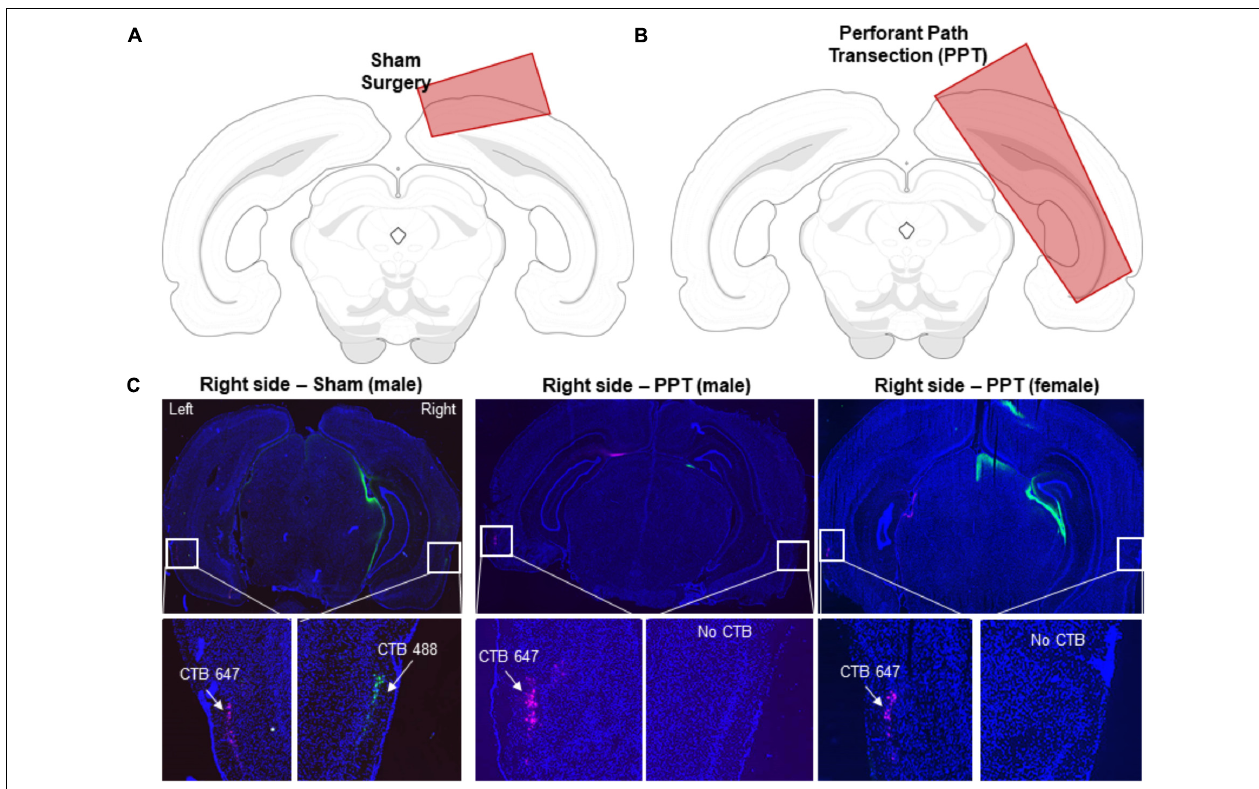
FIGURE 2 | Verification of perforant path fiber transection. (A) Schematic of the extent of the sham knife cut through the cortex in a coronal section of the rat brain. (B) Schematic of the extent of the knife cut used to transect the perforant path in a coronal section of the rat brain. (C) Coronal sections from a control rat (left), a male PPT rat (middle) and a female PPT rat (right). Nuclei were stained with DAPI (blue). The retrograde tracer CTB was placed in the dorsal hippocampus to verify efficacy of perforant transection. CTB-647 (pink) was injected into the left hemisphere as a positive control, and CTB-488 (green) was injected into the right hemisphere. White squares indicate an area of lateral entorhinal cortex in which CTB would be present if perforant path fibers were intact. In the control Sham rats, labeling from both CTB conjugates was evident in both hemispheres. In the PPT rats, there was an absence of green labeled cell bodies of projection neurons in the right entorhinal cortex in the transected